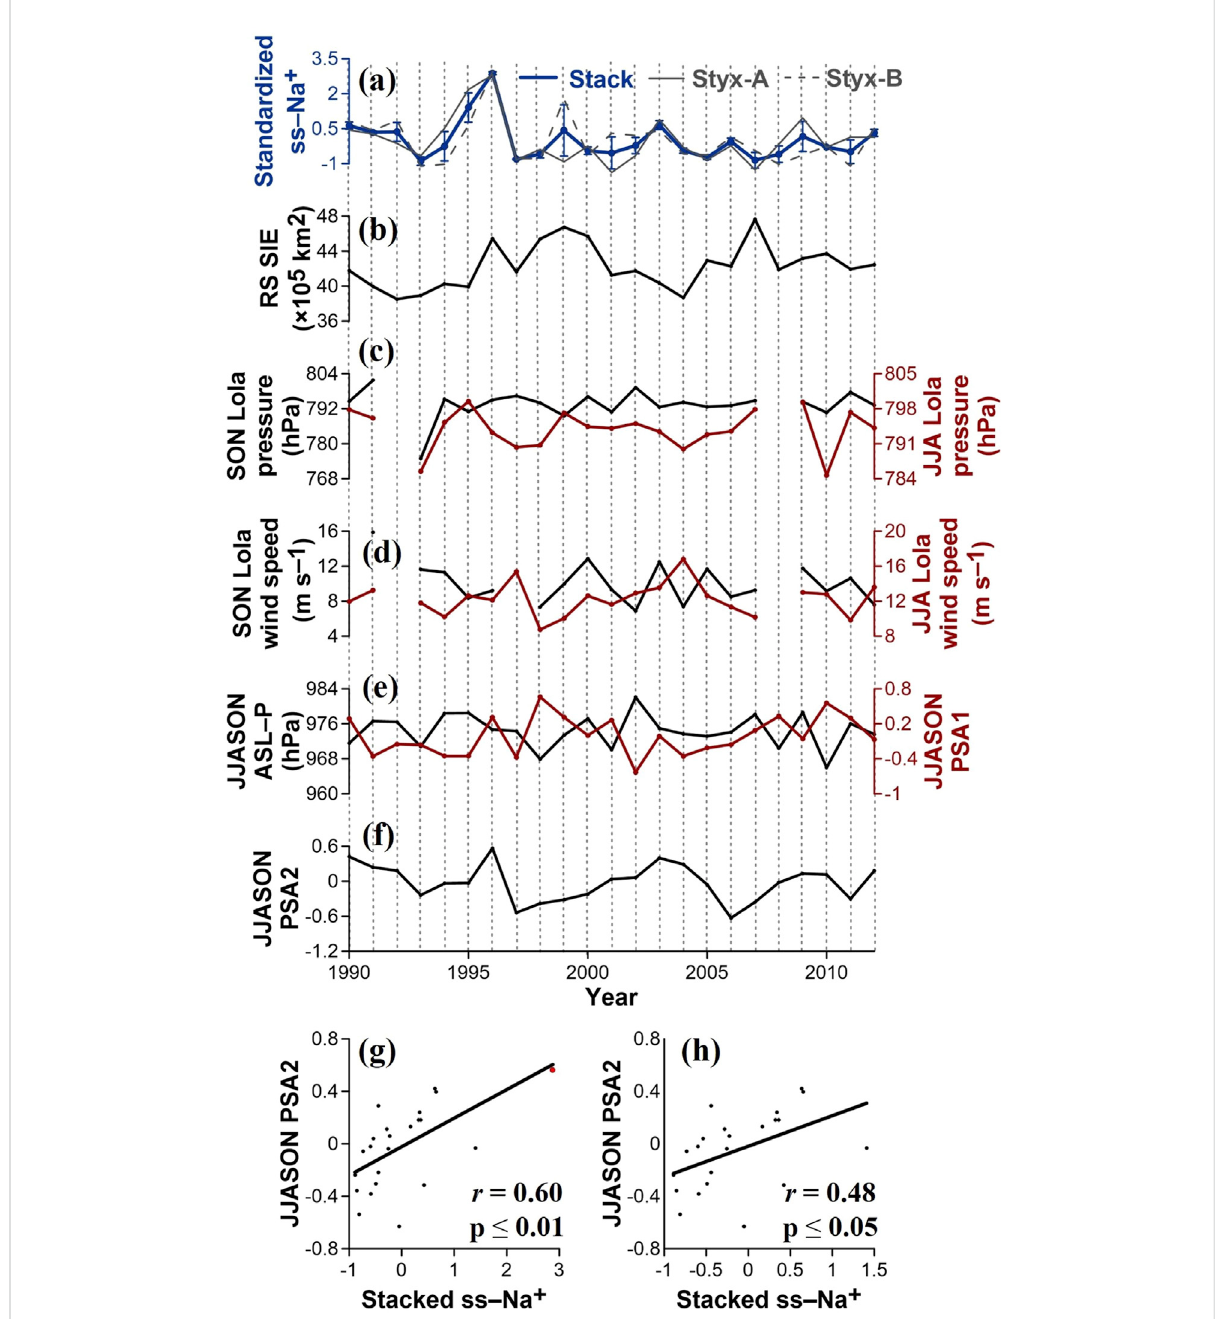
FIGURE 3 (A) Stacked record of annually averaged ss – Na + fl uxes in the Styx-A and -B cores. The stacked pro fi le was produced after standardizing the observed ss – Na + fl ux data (see text). The vertical bars represent the standard error for each annual value. (B) Satellite-derived maximum SIE record for the Ross Sea (RS) sector (see Supplementary Section S1 and Figure 1A), (C) JJA and SON Lola AWS pressure records, (D) JJA and SON Lola AWS windspeedrecords, (E) JJASON ASL – Pindexde fi nedbyHoskingetal.(2013)andPSA1indexde fi nedbyMarshallandThompson(2016),and